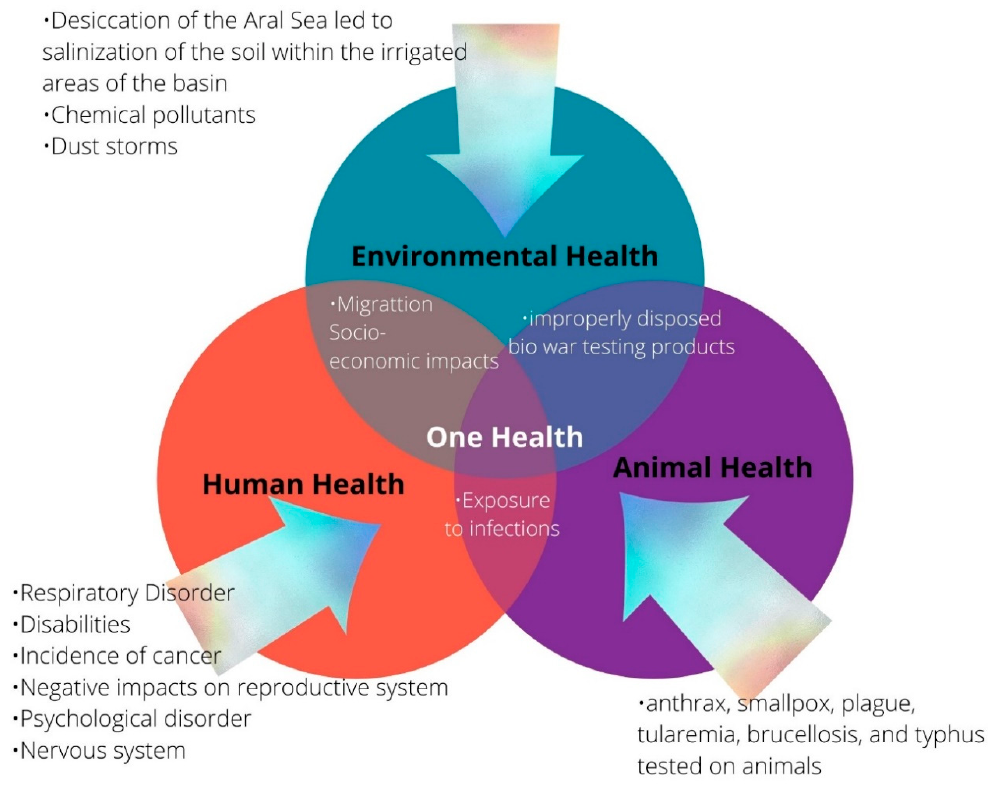
Figure 7. One Health concept adaptation by the authors.